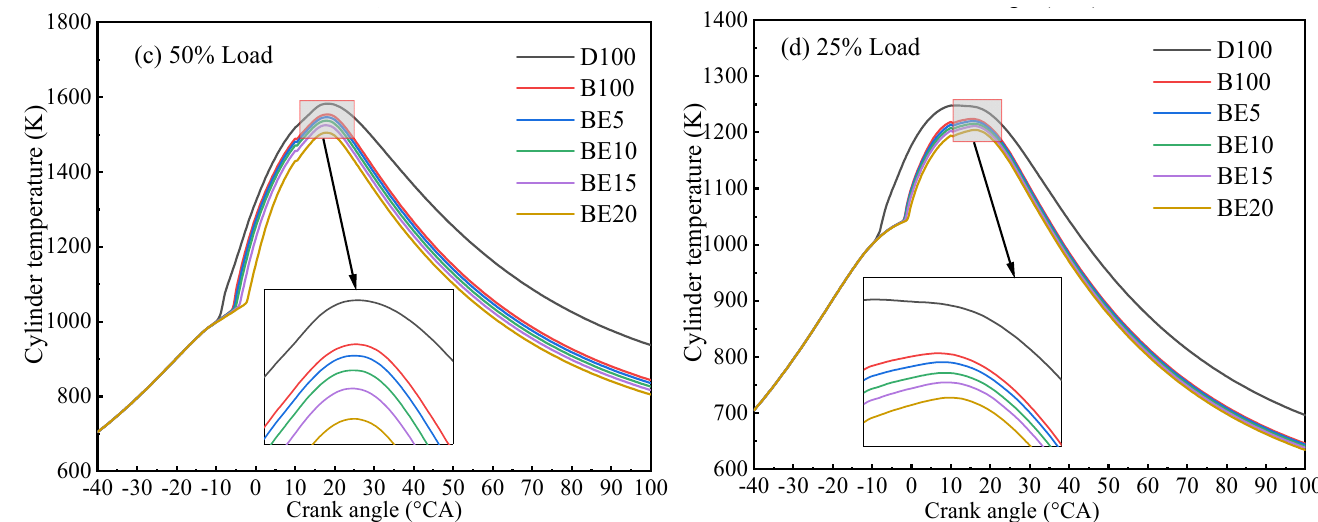
Figure 12. Comparison of cylinder temperature for different blends at different loads. ( a ) 100% Load, ( b ) 75% Load, ( c ) 50% Load, ( d ) 25% Load. Table 5 indicates the in-cylinder temperature distribution field of different fuels at full engine load. It can be seen that the ethanol addition decreases the localized higher temperature zones due to higher latent heat vaporization of ethanol. Moreover, the oxygen content in biodiesel also has a positive effect on improving the combustion characteristics of the blend fuel. With the increase of ethanol addition ratios, the lower latent heat of vaporization of ethanol results in more heat loss. Therefore, the ethanol addition decreases the cylinder temperature. Table 5. Cylinder temperature distribution field in the cylinder at 100% load. − 8 °CA 0 °CA 8 °CA